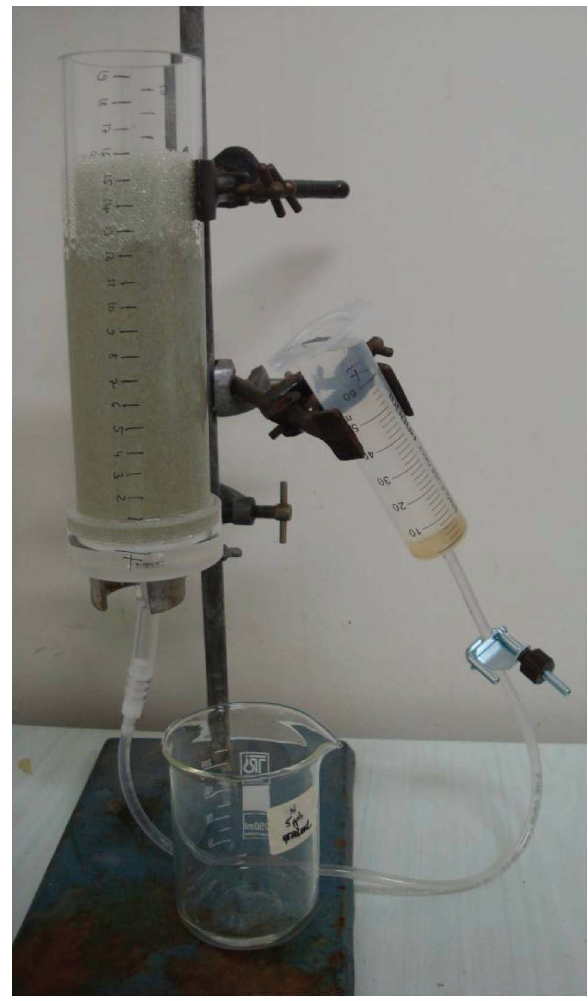
Figure 1. Experimental setup investigating the impact of drawdown on stygofauna. Column filled with glass beads and with water table lowered to 8 cm; note the unsaturated zone in the top 4 cm and the apparently saturated capillary fringe from 8-4 cm; Photo C Stumpp.